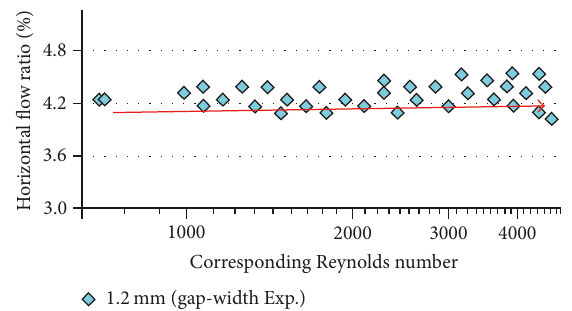
Figure 8: Meshing analysis